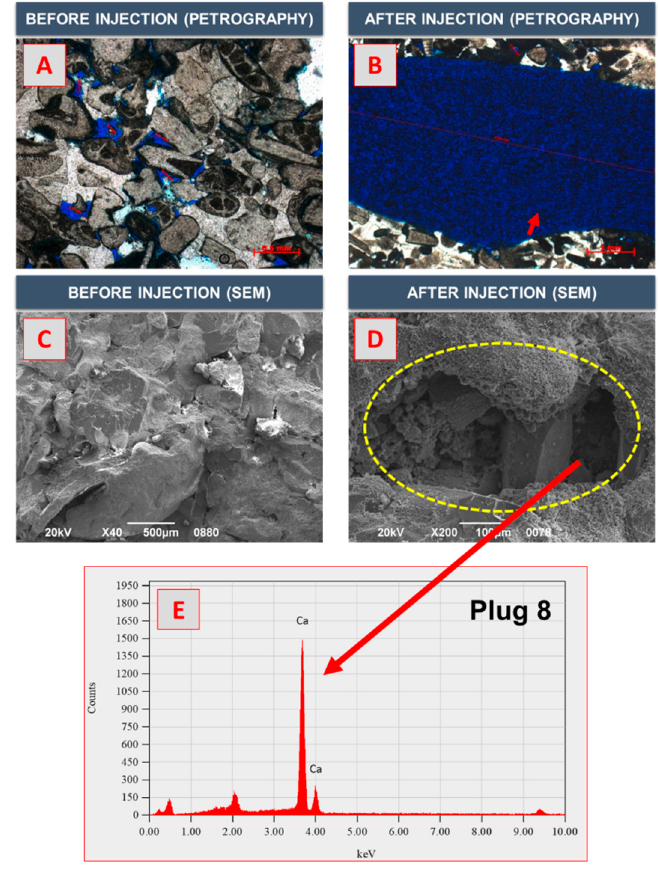
Figure 7. Results of SEM–EDX and thin-section analyses of Plug 8.